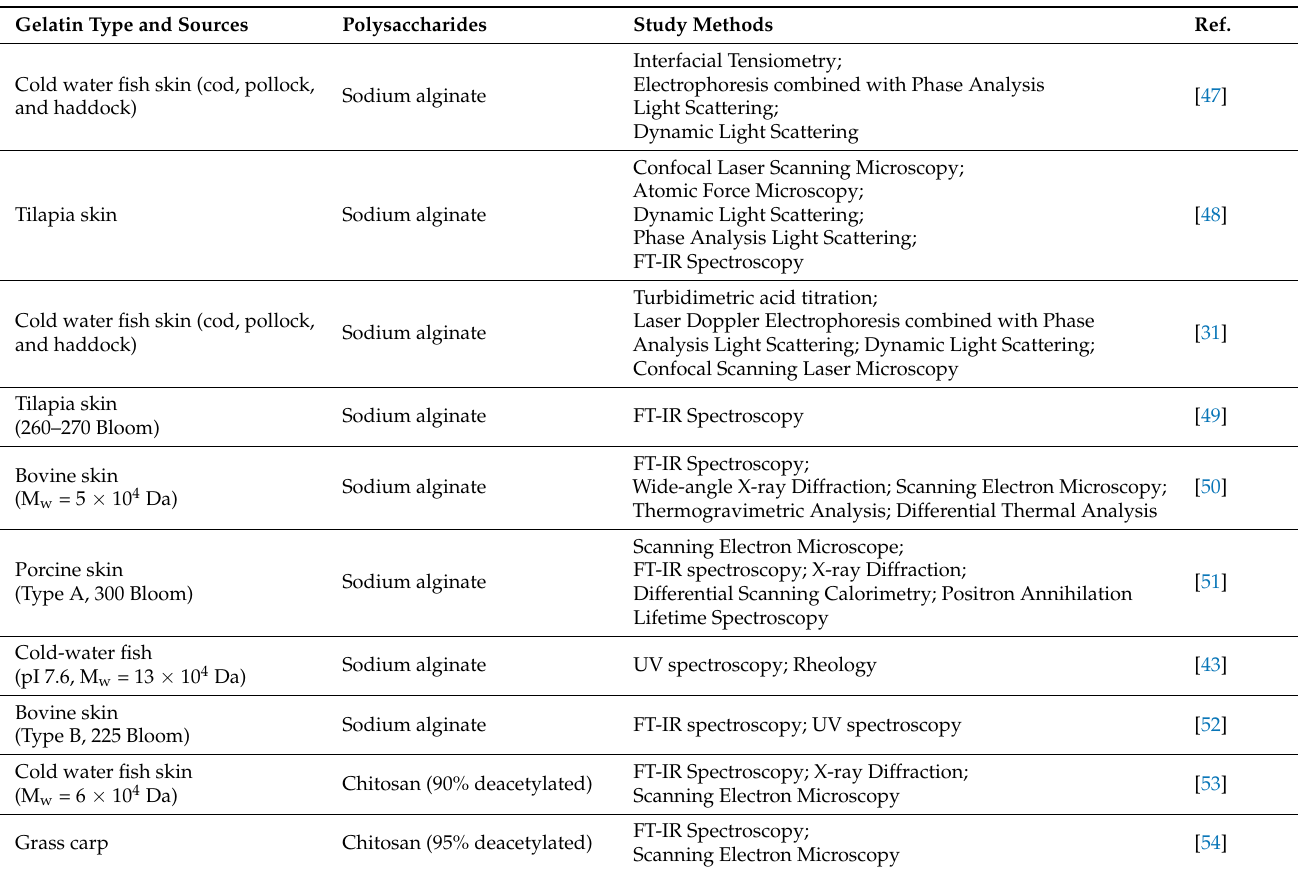
Table 2. Gelatin sources, polysaccharide types, and methods for study of polysaccharide-gelatin complex